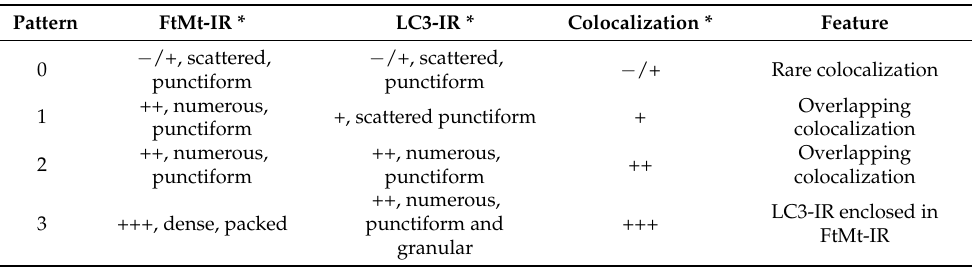
Table 2. Colocalization features of the LC3-IR over the FtMt-IR based on the colocalization patterns of the 3D-modeled